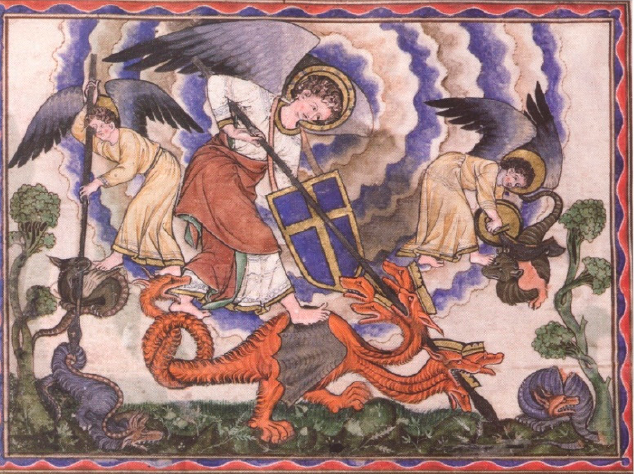
Figure 11. Douce Apocalypse (Oxford, Bodleian Library MS Douce 180). Fol. 44 r , c. 1265–70, © Bodleian Libraries, University of Oxford.